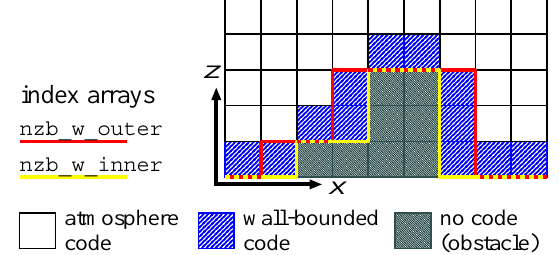
Figure 4. Sketch of the 2.5-D implementation of topography using the mask method (here for w ). The yellow and red lines represent the limits of the arrays nzb_w_inner and nzb_w_outer as de- scribed in Sect. 4.3,